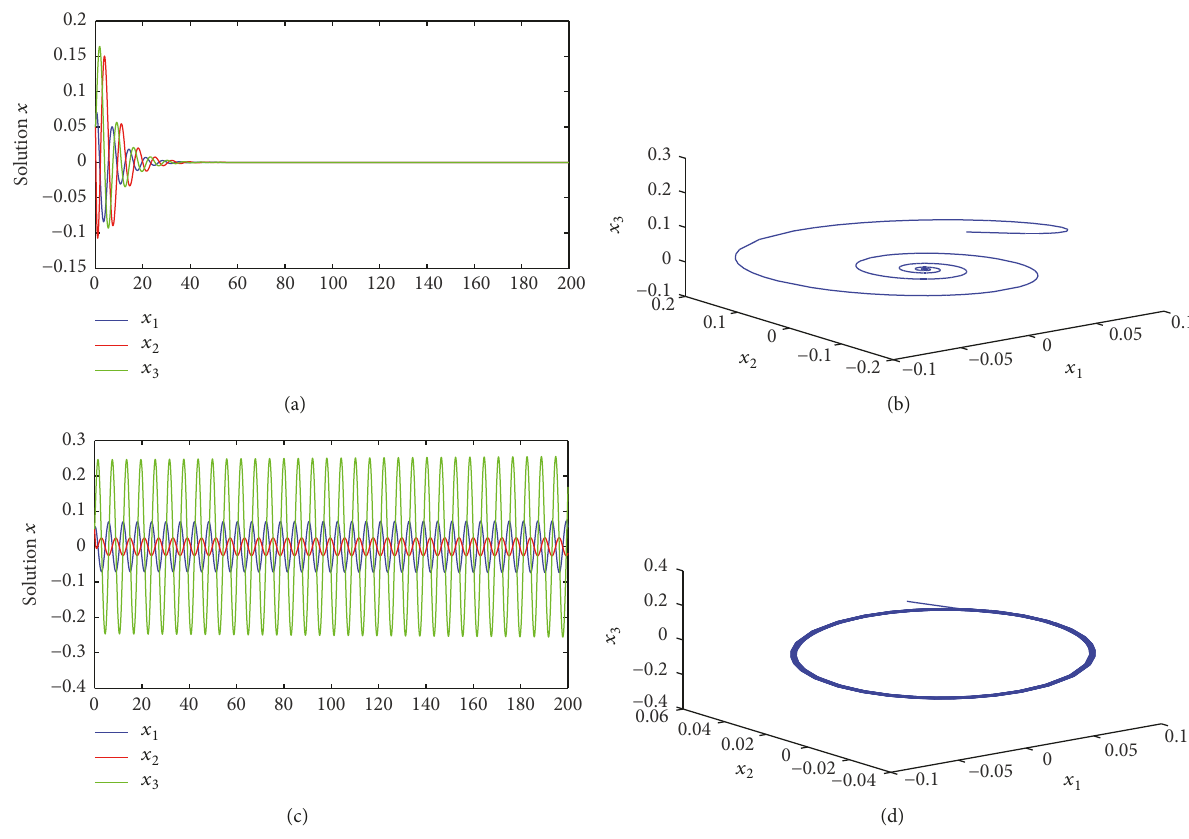
Figure 2: Time waveforms and phase portrait of the PI hydroturbine governing system. (a) Time waveforms with 𝐾 𝑃 = 4.5, 𝐾 𝐼 = −1.326 , and 𝜏 < 0.35 s. (b) The phase portrait with 𝐾 𝑃 = 4.5 , 𝐾 𝐼 = −1.326 , and 𝜏 = 0.15 s. (c) Time waveforms of 𝑥 𝑖 (𝑡) with 𝐾 𝑃 = 1.1 , 𝐾 𝐼 = −3.6326 , and 𝜏 ≥ 0.35 s. (d) The phase portrait with 𝐾 𝑃 = 1.5 and 𝜏 = 0.4 s.